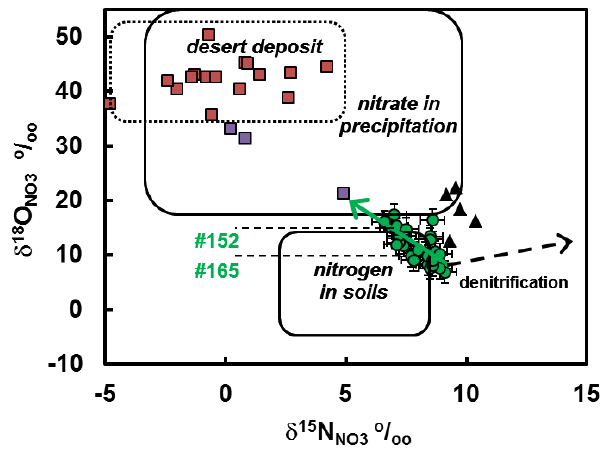
Fig. 5. 18 O/ 16 O versus 15 N/ 14 N distribution in nitrate (adapted from Kendall, 1998). 18 O NO3 and 15 N values are referred to the VSMOW and AIR standards, respectively.